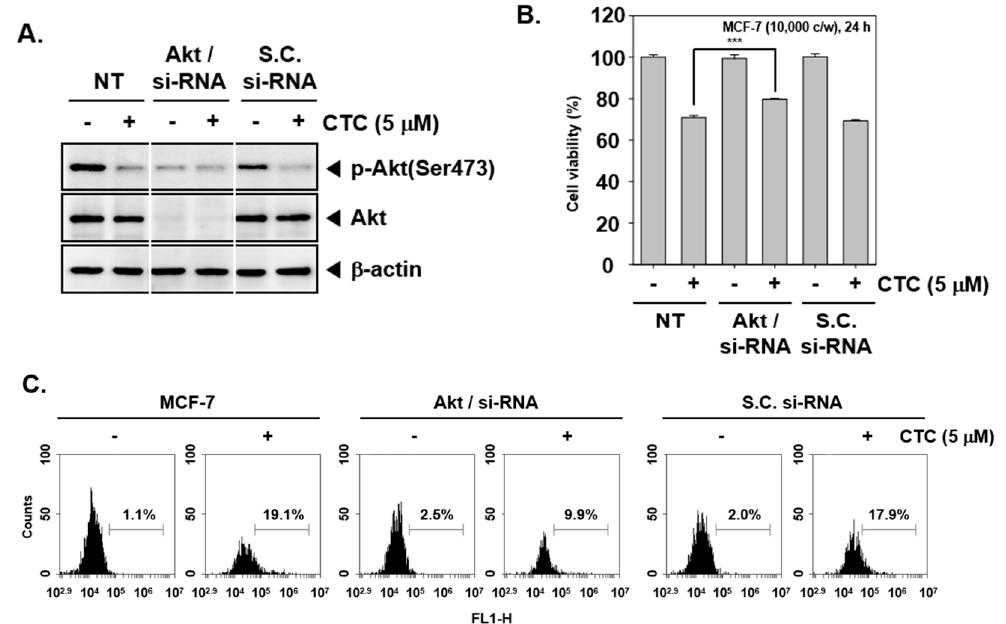
Figure 4. The role of Akt in growth inhibitory effects of CTC. ( A ) MCF-7 cells were transiently transfected with Akt/si-RNA or scrambled si-RNA (control). Then, whole cell extracts were prepared and western blot analysis was performed as described above in panel 1C. ( B ) Akt/scrambled si-RNA transfected MCF-7 cells were treated with 5 µM of CTC for 24 h. Thereafter, cell viability was measured using MTT assay; ( C ) Cellular apoptosis was determined using TUNEL assay.